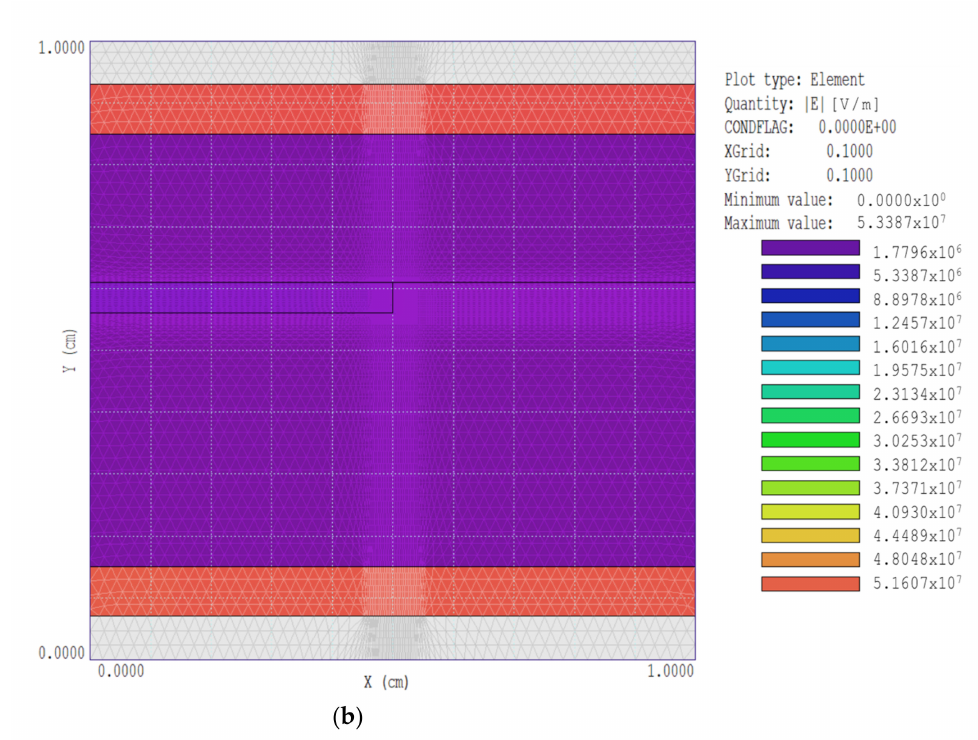
Figure 16. Simulation result of electric field distribution for configuration (6). ( a ) With polyimide film; ( b ) without polyimide film.